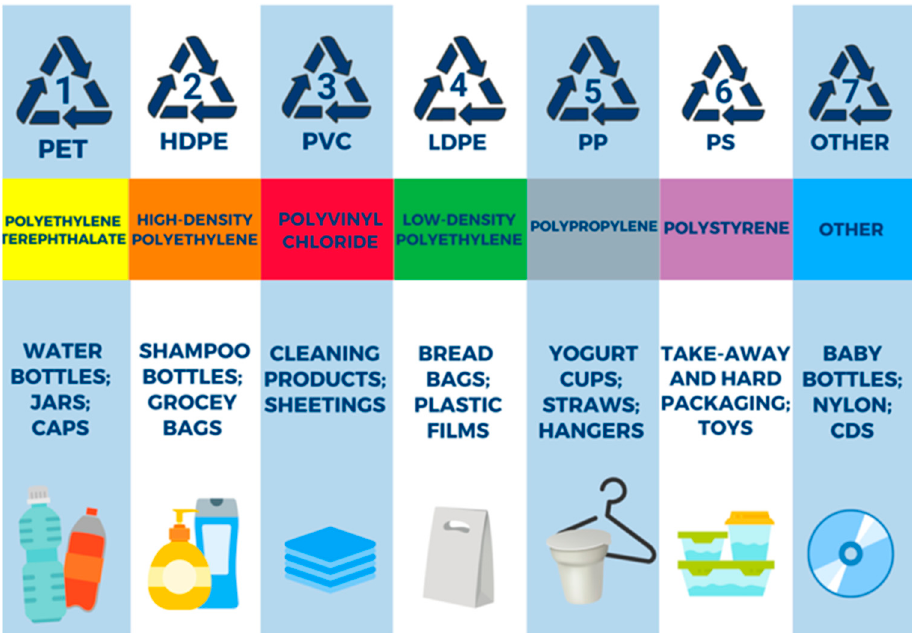
Figure 4. Categories of polymer plastic depending on their uses (after https://www.plasticsforchange.org/blog/different-types-of-plastic, accessed on 26 September